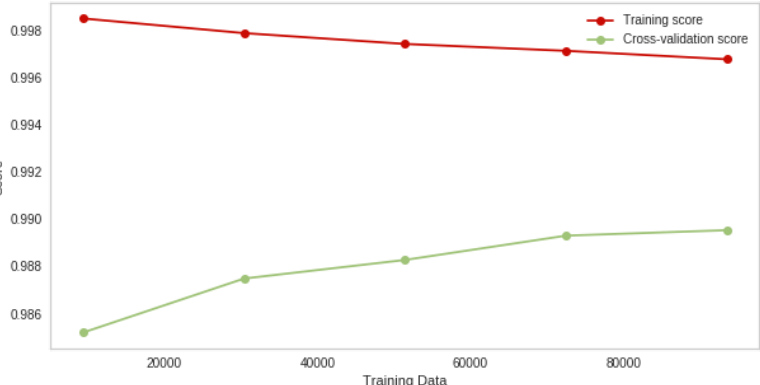
Figure 15. Binary class random forest training and validation learning.